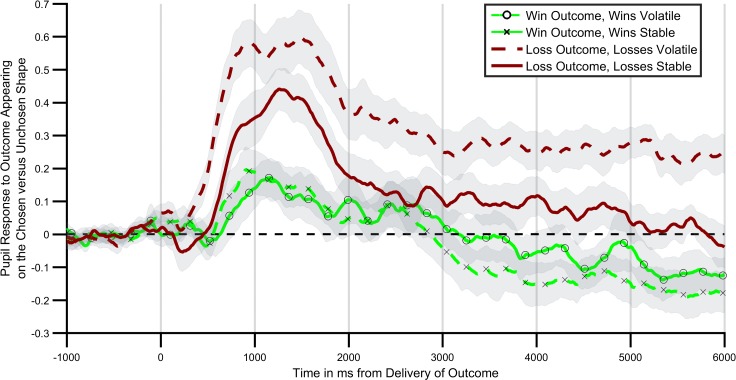
Pupil response to outcome delivery during the learning task.Lines illustrate the mean pupil dilation to an outcome when it appears on the chosen relative to the unchosen shape, across the 6 s after outcomes were presented. Light green lines (with crosses and circles) report response to win outcomes, dark red lines report response to loss outcomes. Solid lines report blocks in which the wins were more informative (volatile), dashed lines blocks in which losses were more informative. As can be seen pupils dilated more when the relevant outcome was more informative, with this effect being particularly marked for loss outcomes. Shaded regions represent the SEM. Figure 3—figure supplement 1 plots the timecourses for trials in which outcomes were or were not obtained separately, and Figure 3—figure supplement 2 reports the results of a complimentary regression analysis of the pupil data.